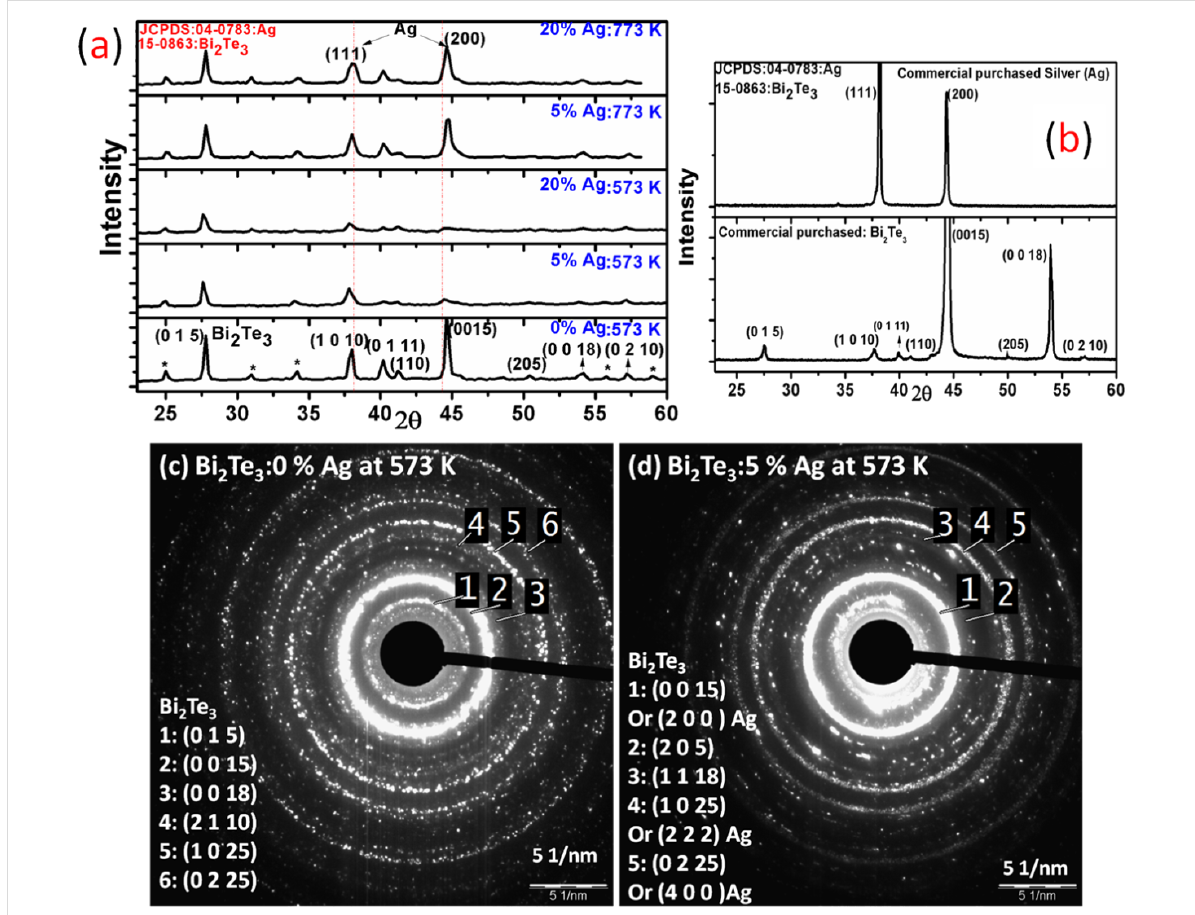
Figure 1: (a) XRD of Bi 2 Te 3 with different concentration of Ag (0, 5, 20%) for annealing temperature 573 K, 773 K, (b) XRD of commercial purchased Ag, Bi 2 Te 3 powder without annealing. SAED pattern of (c) Bi 2 Te 3 and (d) Ag (5%) for annealing temperature 573 K.